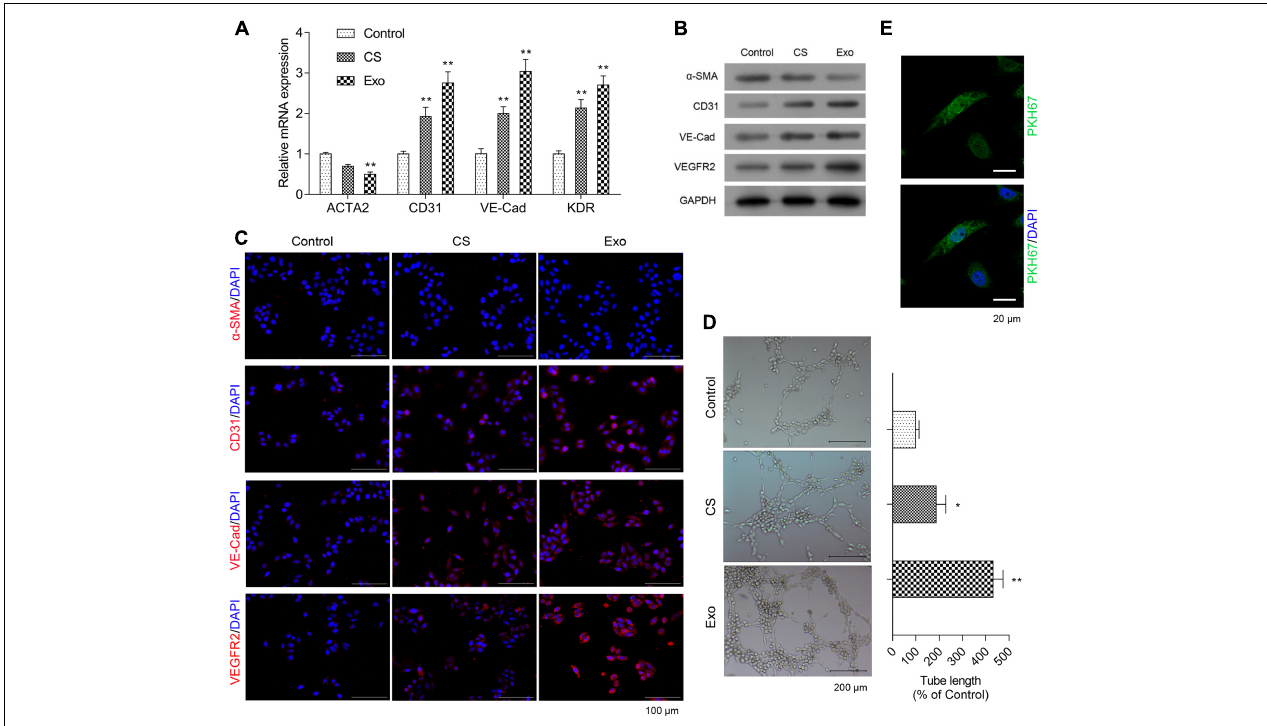
FIGURE 2 | Exosomes from EPCS enhanced angiogenesis and proliferation of HCFs. In the HCFs treated with control (PBS), cell supernatant (CS), or exosomes from EPCs (Exo), the transcriptional expressions of ACTA2, CD31, VE-Cadherin (VE-Cad), and VEGFR2 were determined by qRT-PCR (A) , and the expressions of α -SMA, CD31, VE-Cad, and VEGFR2 were determined by western blot (B) and immunofluorescence staining (C) . Additionally, the angiogenesis was examined by tube formation assay (D) , and the cell proliferation was determined by a fluorescent probe, PKH67 (E) . The cells were treated with exosomes (4 µ g/ml) of EPCs for 24 h. N = 3. * P < 0.05 and ** P < 0.01 vs. control group. HCFs, human cardiac